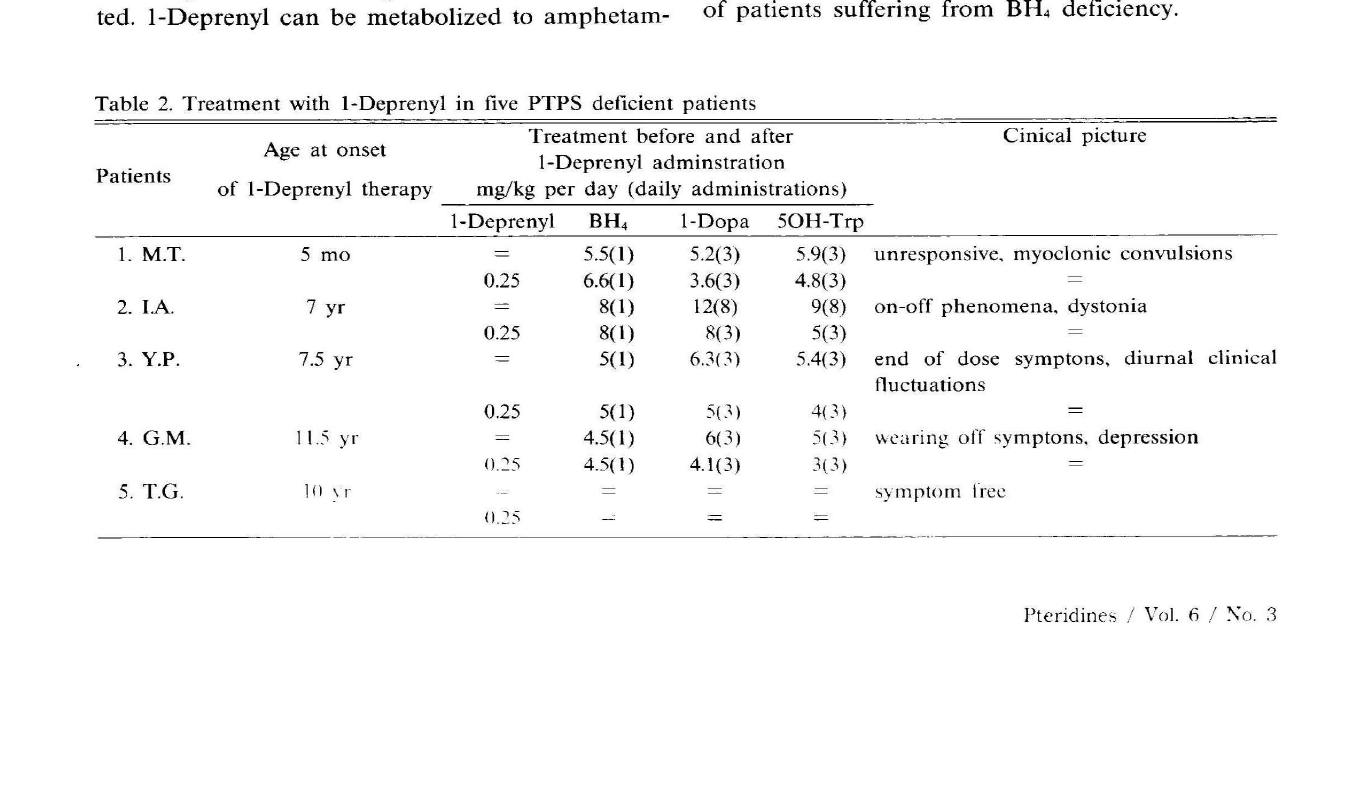
Table 2. Treatment with I-Deprenyl in five PTPS deficient patients